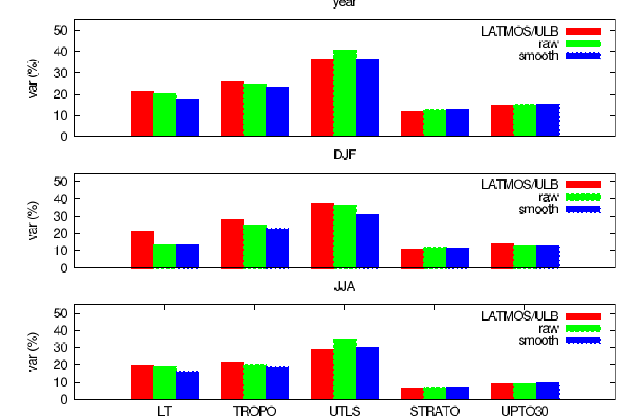
Fig. 7. Same as Fig. 6 for the LATMOS/ULB